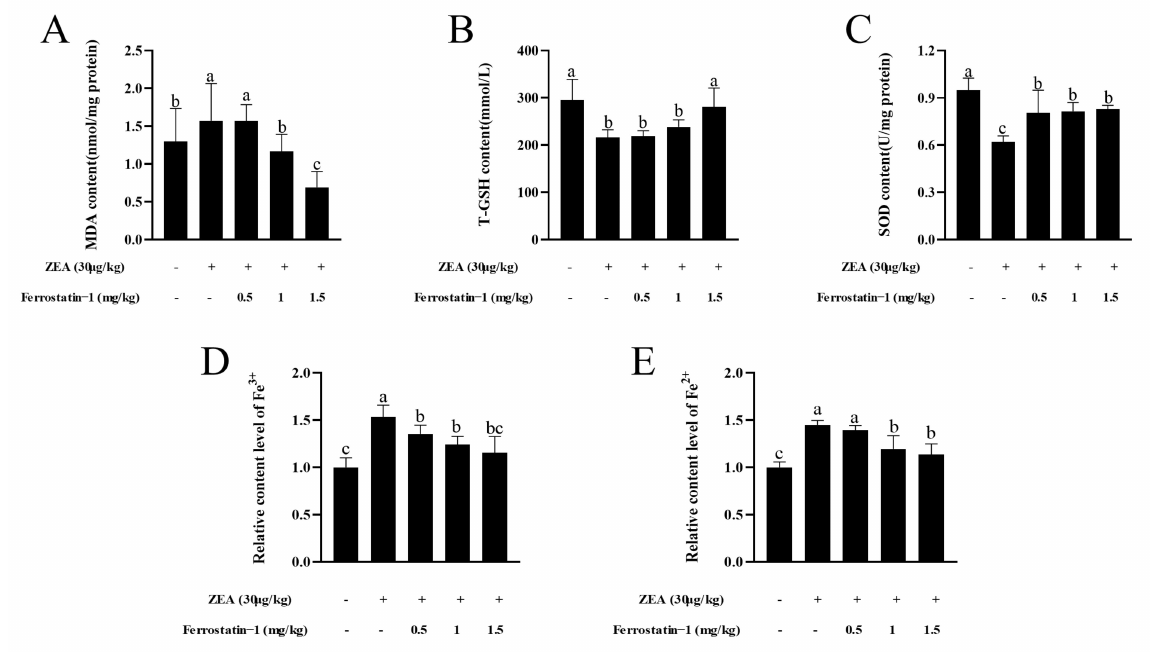
Figure 4. Oxidation indicators and iron detection related to ferroptosis. ( A ) MDA content. ( B ) Total GSH content. ( C ) SOD content. ( D ) Relative content level of Fe 3+ . ( E ) Relative content level of Fe 2+ . The data are expressed as means ± SEM, n ≥ 3; Different lowercase letters (a, b, c) indicate significant differences ( p <